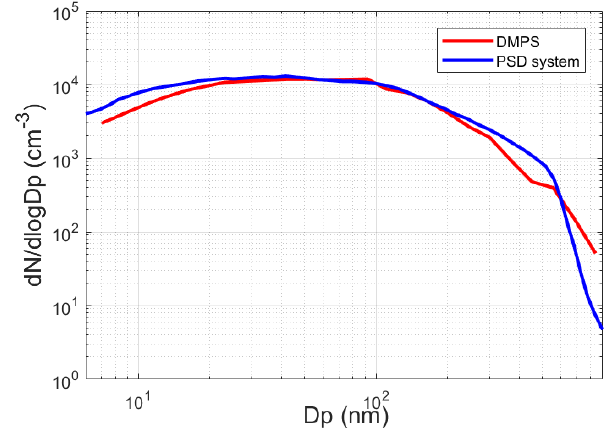
Figure 3. Median particle number size distribution in 5–900nm measured by the DMPS and PSD system during our observation from 1 June to 31 August 2019 at the UB station. The time window of the data is from 09:00–15:00 of every